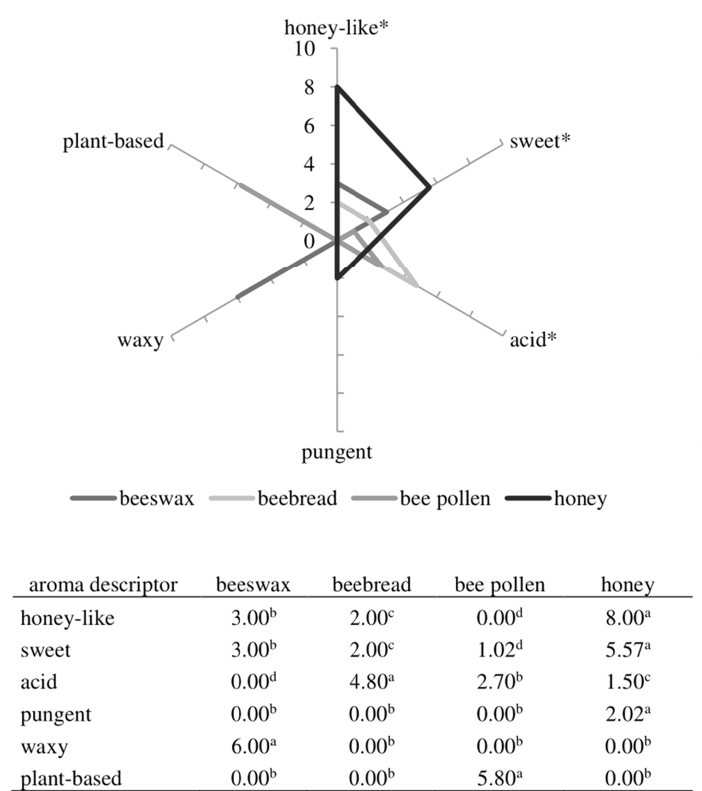
Figure 2. Spider diagram of mean scores of aroma attributes of bee products. Different letters in the same row and “*” in the graph mean significantly different ( p < 0.001).